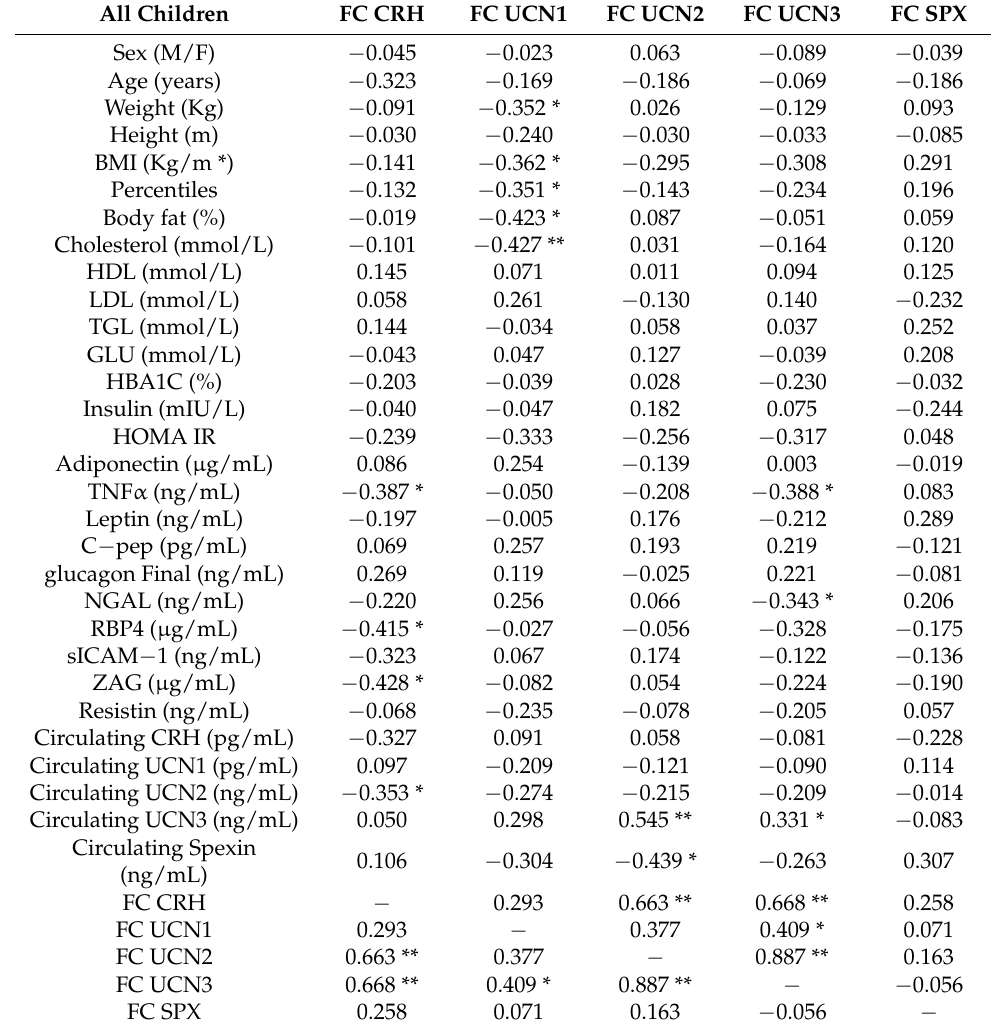
Table 2. Spearman correlation ranking of neuropeptides with study